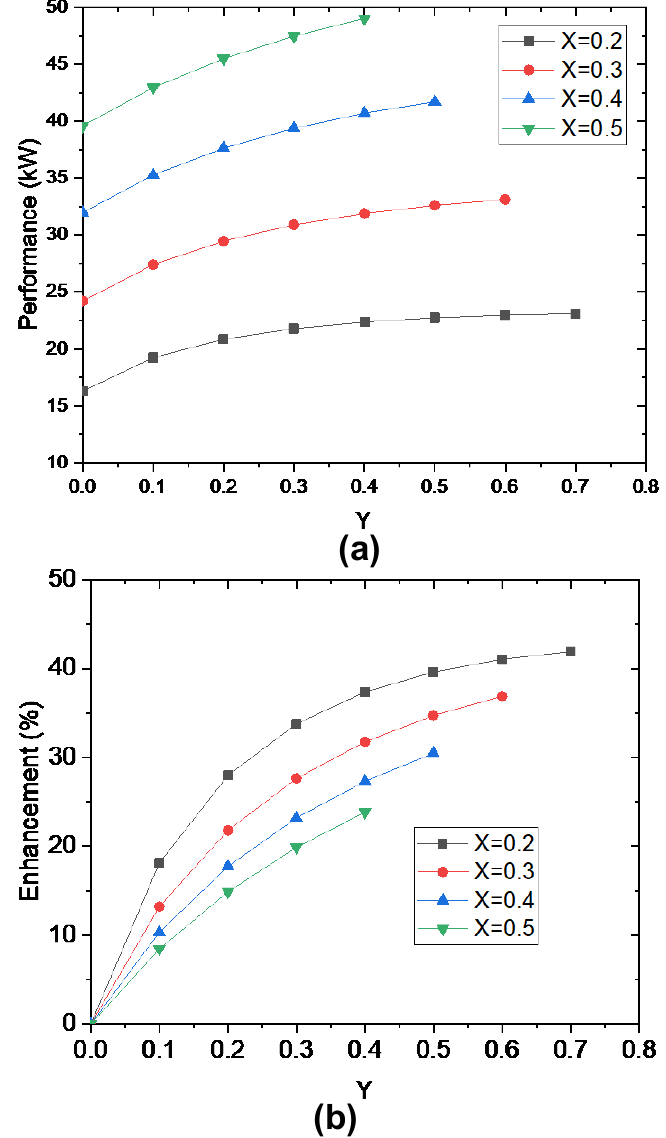
Figure 12. Thermal performance and its enhancement versus ( a ) axial and ( b ) lateral distances. The performance enhancement percentage indicates the additional heat removal from the water stream with the inclusion of the diffuser relative to the basic case where no diffuser is